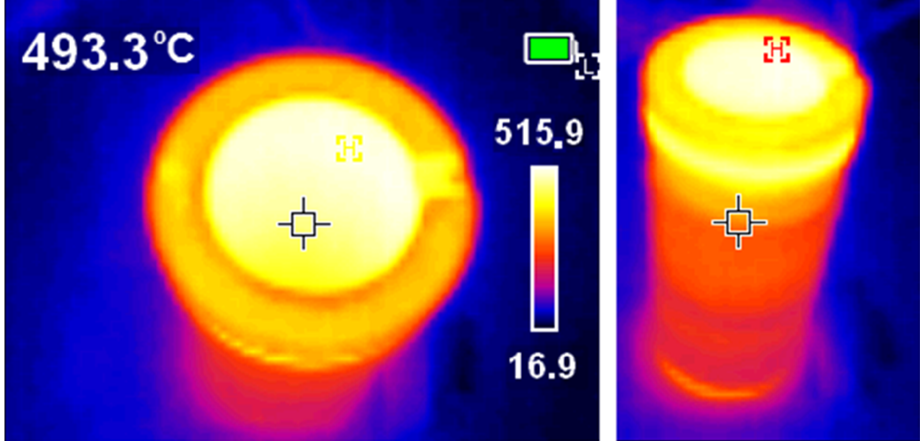
Figure 13. Infrared image of the graphene crucible, given in Figure 6.